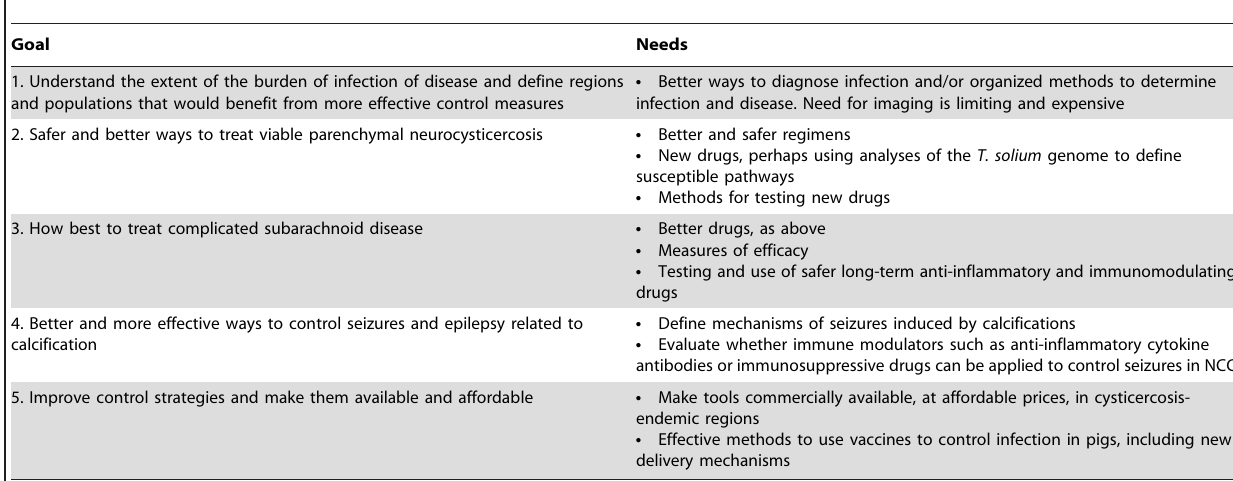
Table 1. Major goals and needs for the management and control of neurocysticercosis.